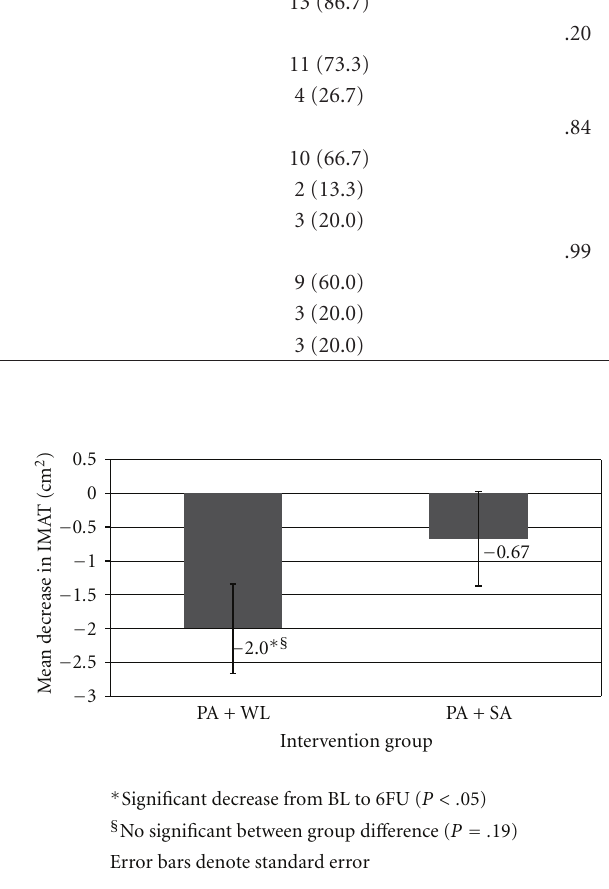
Figure 1: Mean change in IMAT (cm 2 ) from baseline to 6-month followup by intervention